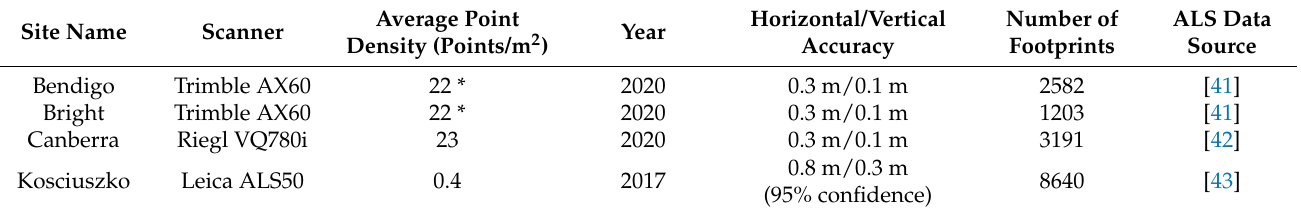
Table 3. Technical specifics of the airborne laser scanning (ALS) data sets from the four study